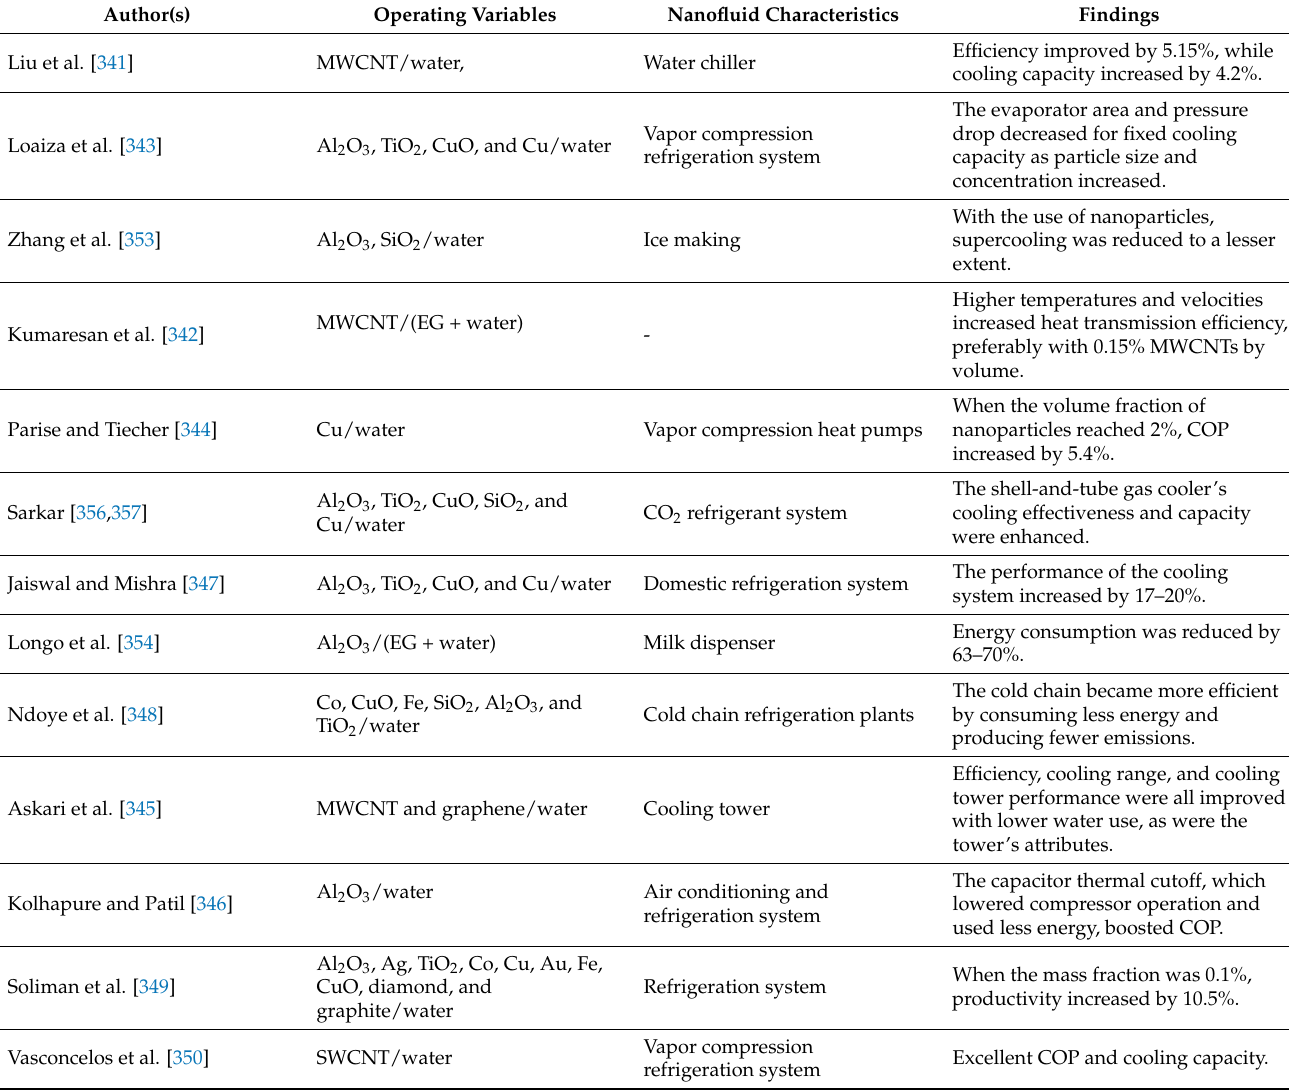
Table 9. Summary of the application of nanofluids as coolant and secondary